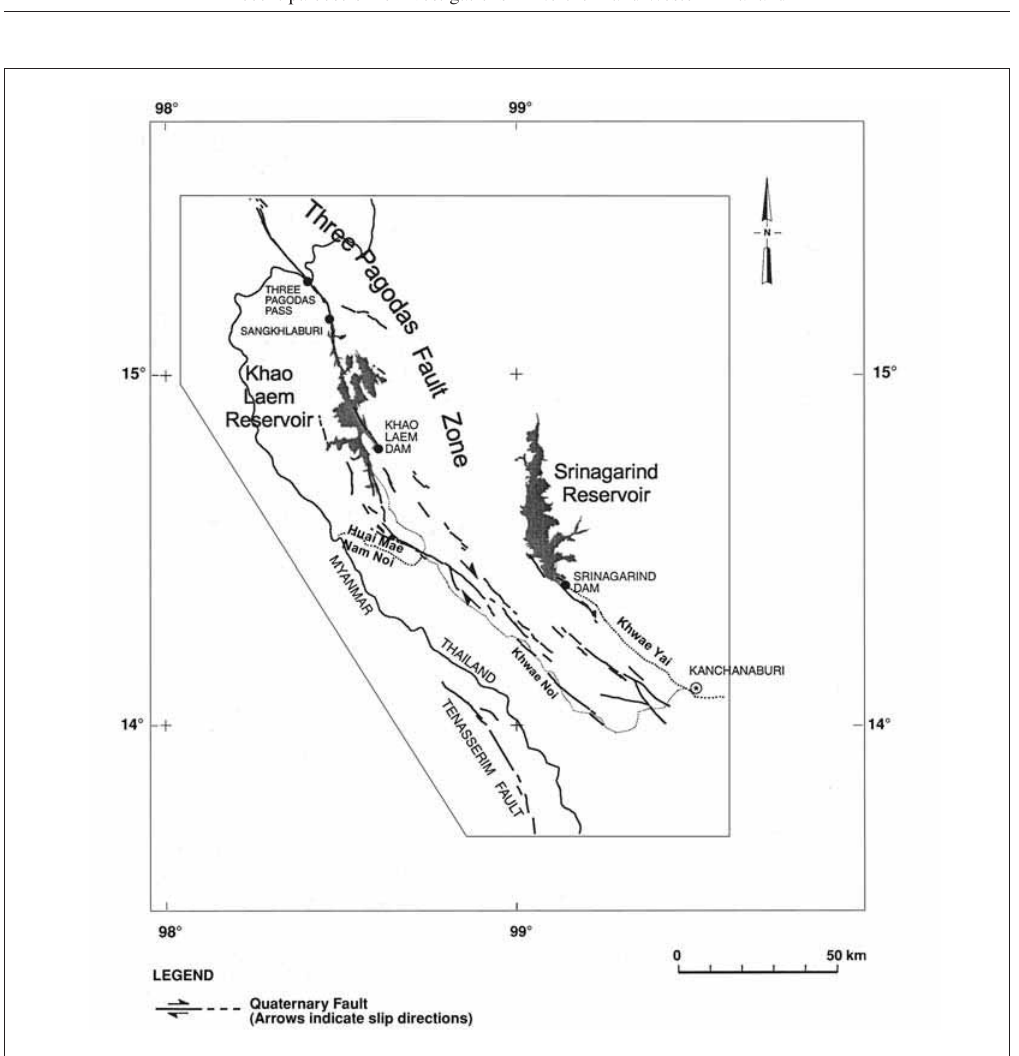
Fig. 16. Simplified map of the Three Pagodas Fault Zone showing localities mentioned in the